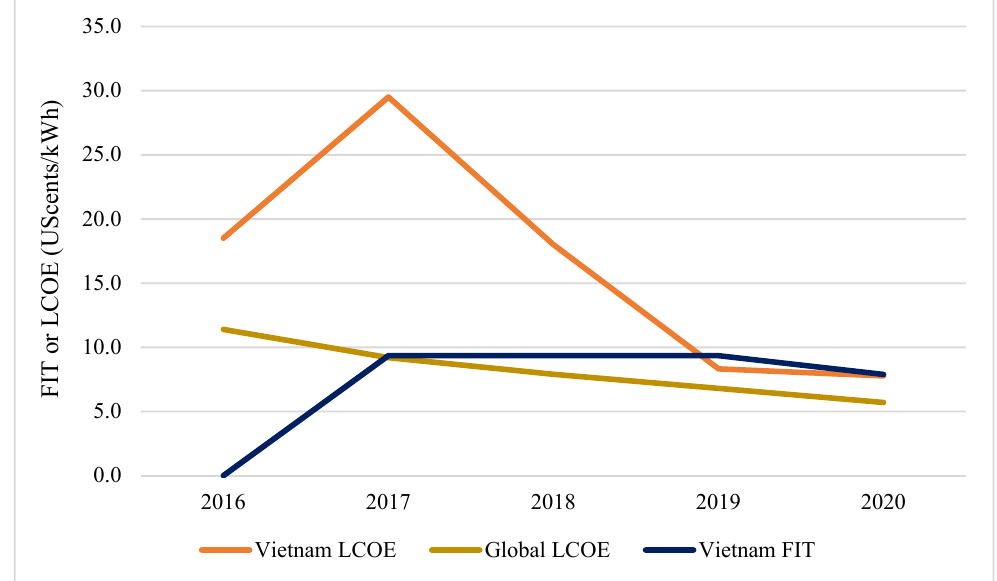
Figure 11. Weighted-average LCOE/FIT in Vietnam and LCOE of the World. Reprinted with per- mission from Refs. [4,9,10]. Copyright 2020 Energies; Copyright 2020/2021 International Renewa- ble Energy Agency.